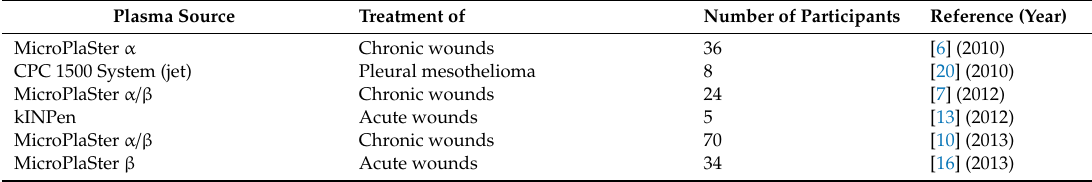
Table 1. Clinical trials and case reports of CAP application for treatment of chronic and acute wounds, as well as (pre-)cancerous